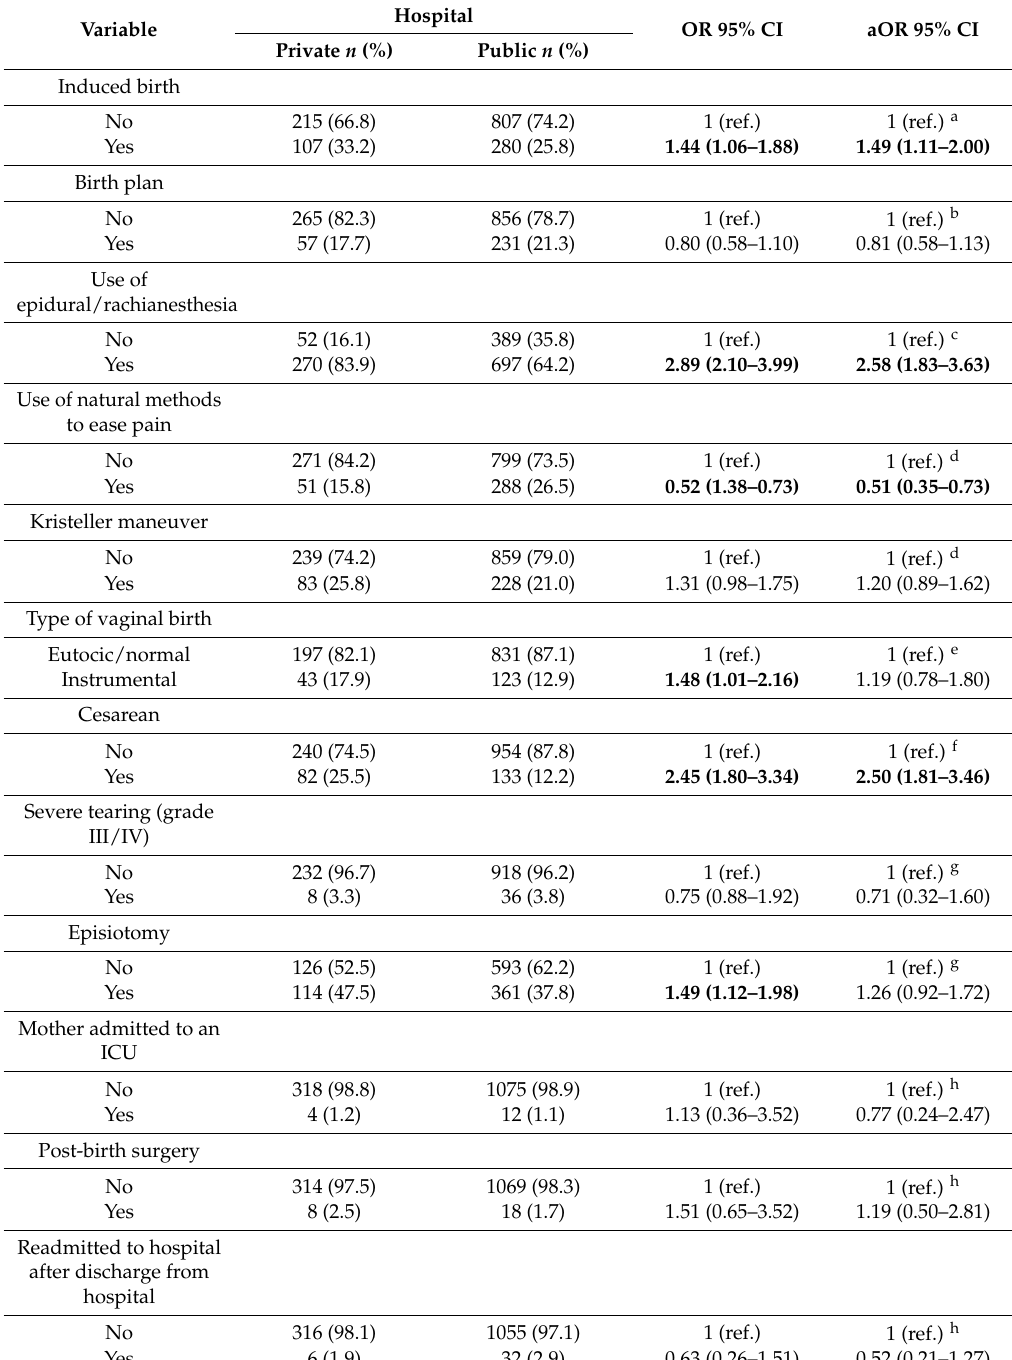
Table 3. Association between the type of hospital (public or private) where delivery occurs and the probability of some clinical practices in multiparous